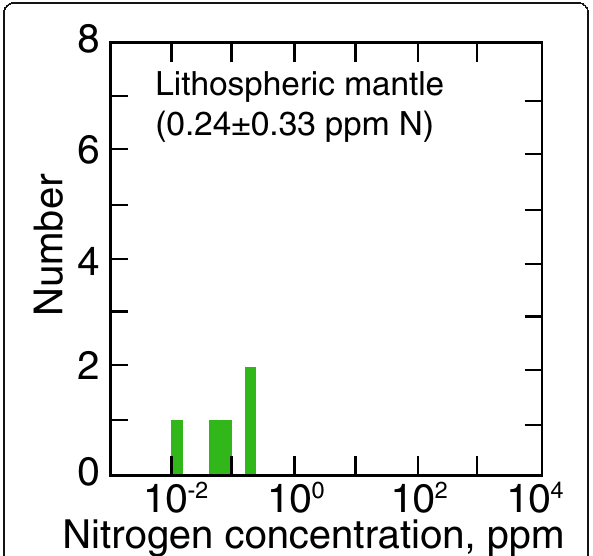
Fig. 5 Distribution of nitrogen concentrations in mantle rocks modified after Johnson and Goldblatt